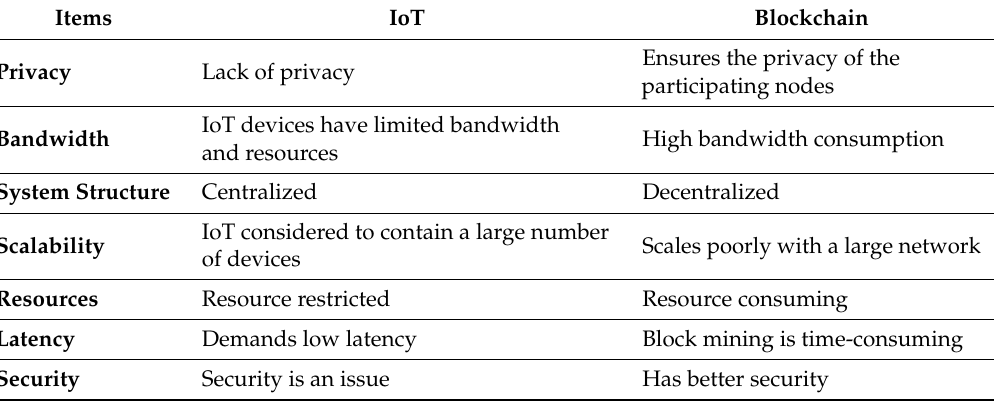
Table 2. A simple comparison between IoT and blockchain.